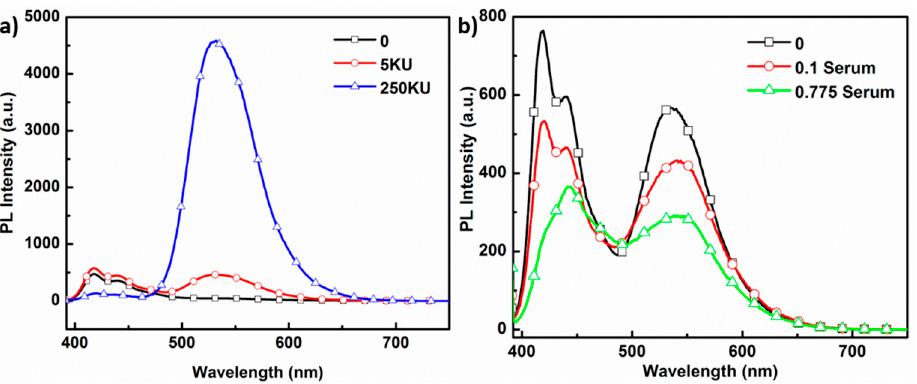
Figure 7. ( a ) PL spectra of PFC3NBT in PBS (pH = 7.4) in the absence and presence of CA153 at the concentration of 0 ku, 5 ku and 250 ku. ( b ) PL spectra of PFC3NBT in PBS (pH = 7.4) in the presence of CA153 = 5 ku with a different fraction of serum in PBS/serum mixture (fraction calculated by v / v ). RU = 4.5 μ M. Excitation at 380 nm.